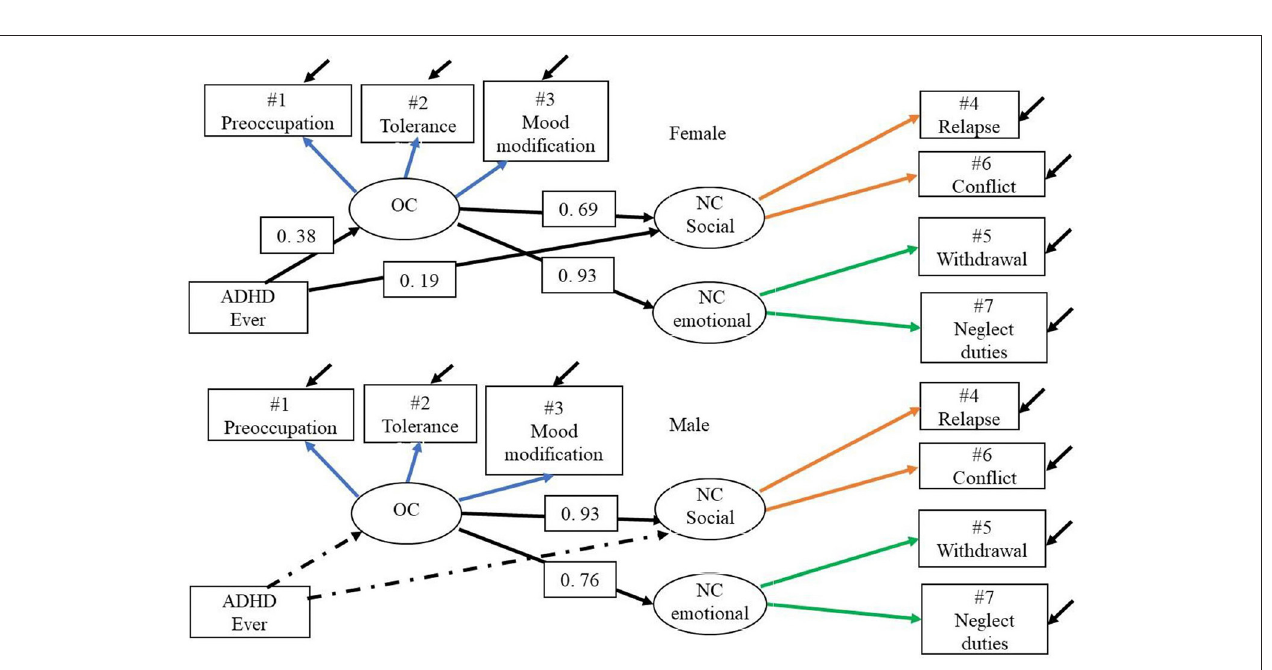
FIGURE 4 | Model 3.2g.dia—GASA MGCFA 3 by gender, metric with covariate. The two-group three-factor model with equality constraints across gender for corresponding measurement models and with covariate ADHD ever. Dotted line is non-significant path. OC, over consumption; NC, negative consequences. male gamers but also that their negative consequences of as was the case for female gamers. ADHD was significantly over consumption tend to be social rather than emotional, associated with over consumption of video games and